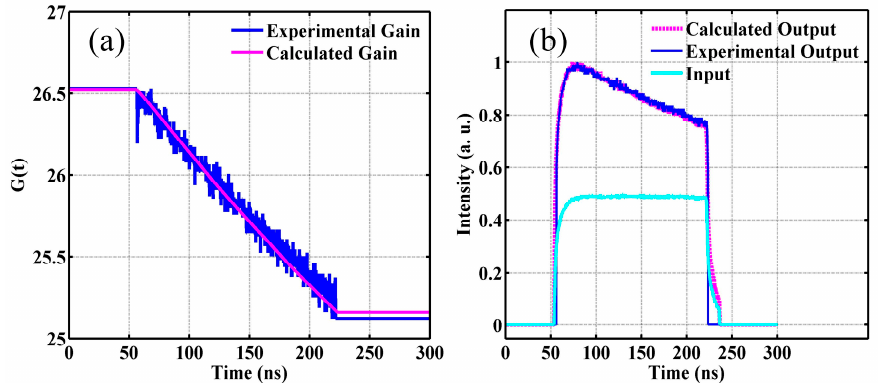
Figure 4. ( a ) Pulse shape transfer function from experiment and simulation. ( b ) Output pulse shape from experiment and simulation with the same input pulse shape.